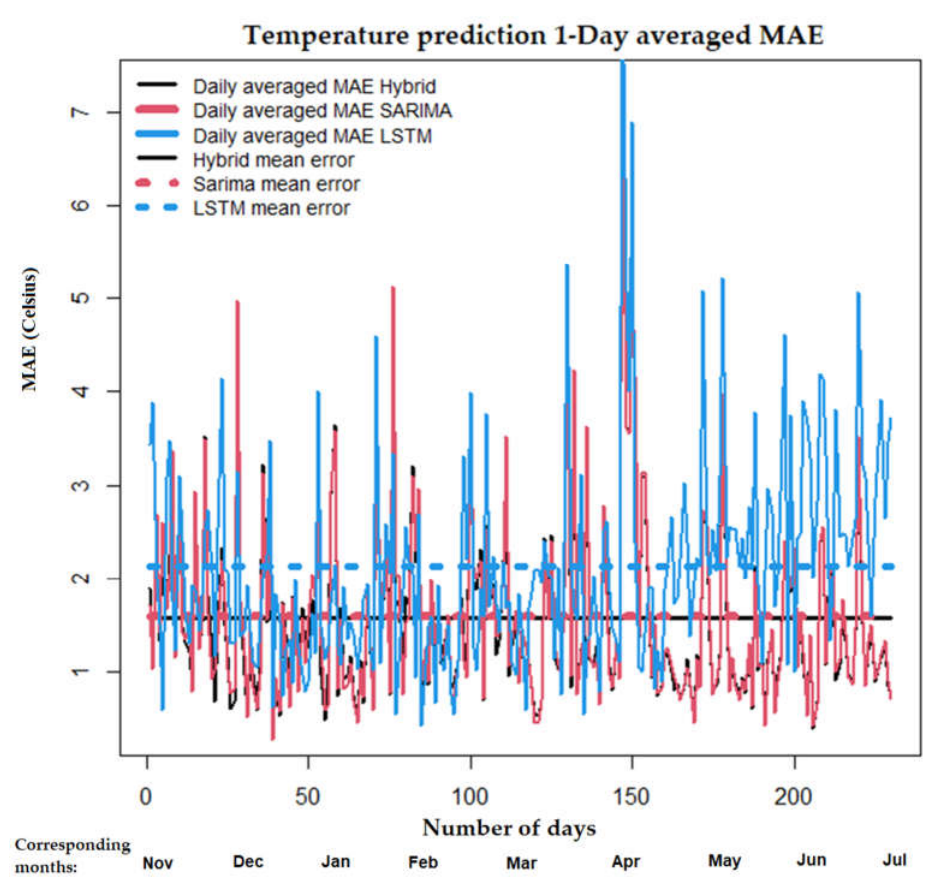
Figure 2. Comparison of SARIMA, LSTM and hybrid using daily averaged MAE with real data for 1-day prediction horizon for 230 days of the test set. With dashed lines the average error of all the dataset is shown. Units of MAE are in Celsius in this temperature example.